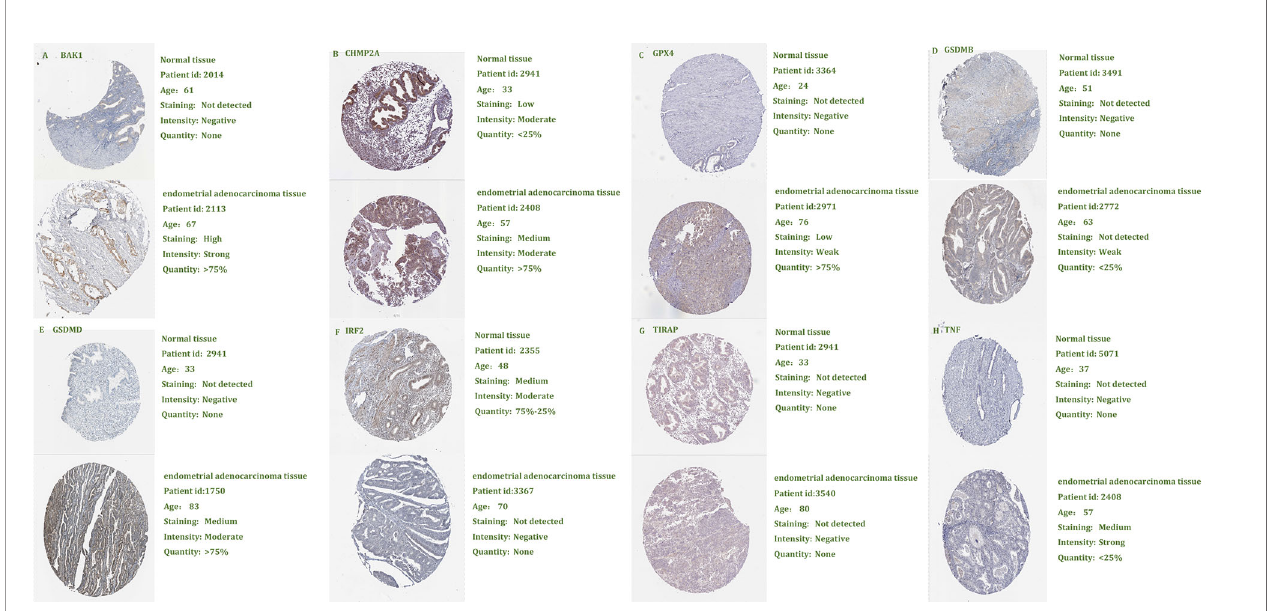
FIGURE 9 | Validation of eight pyroptosis-related genes by The Human Protein Atlas database.